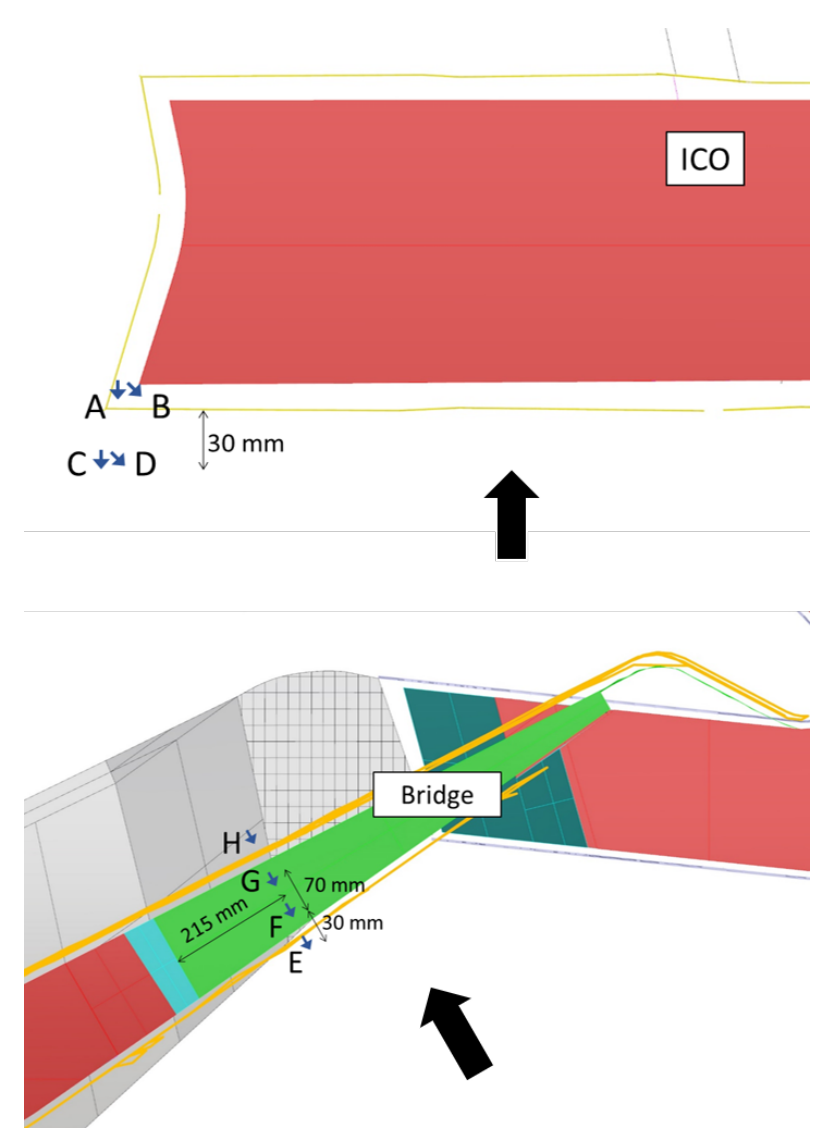
Figure 16. Cobra